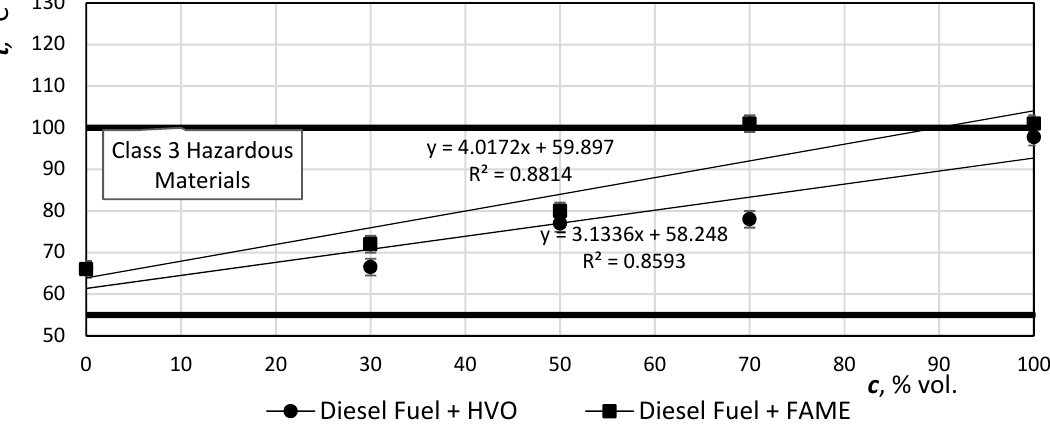
Figure 10. Flash points of diesel fuel with HVO and FAME.